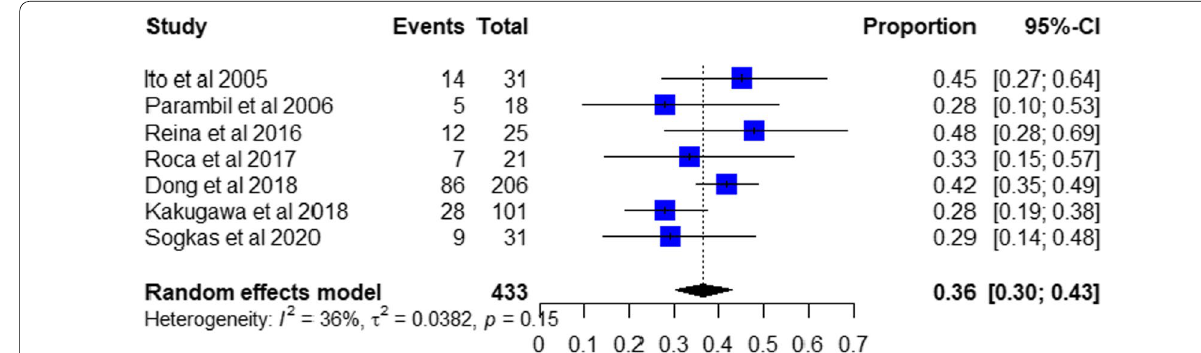
Fig. 5 Meta‑analysis of the Non‑specific interstitial pneumonia in patients with Sjogren’s syndrome